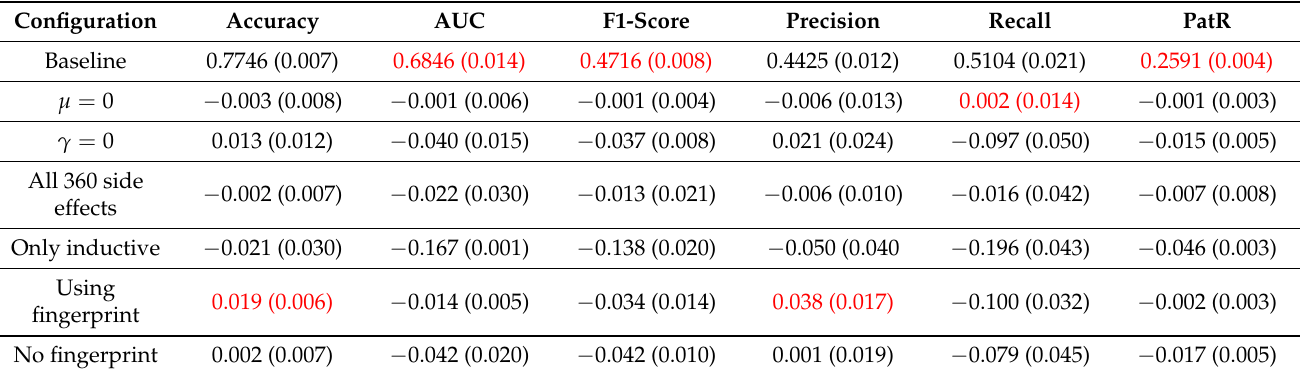
Table 3. Ablation study of MolecularGNN. Values are shown as the means (std) of the results of 10 learning procedures each. In red are the best result for each metrics. Baseline is the MolecularGNN model architecture, as described in Table